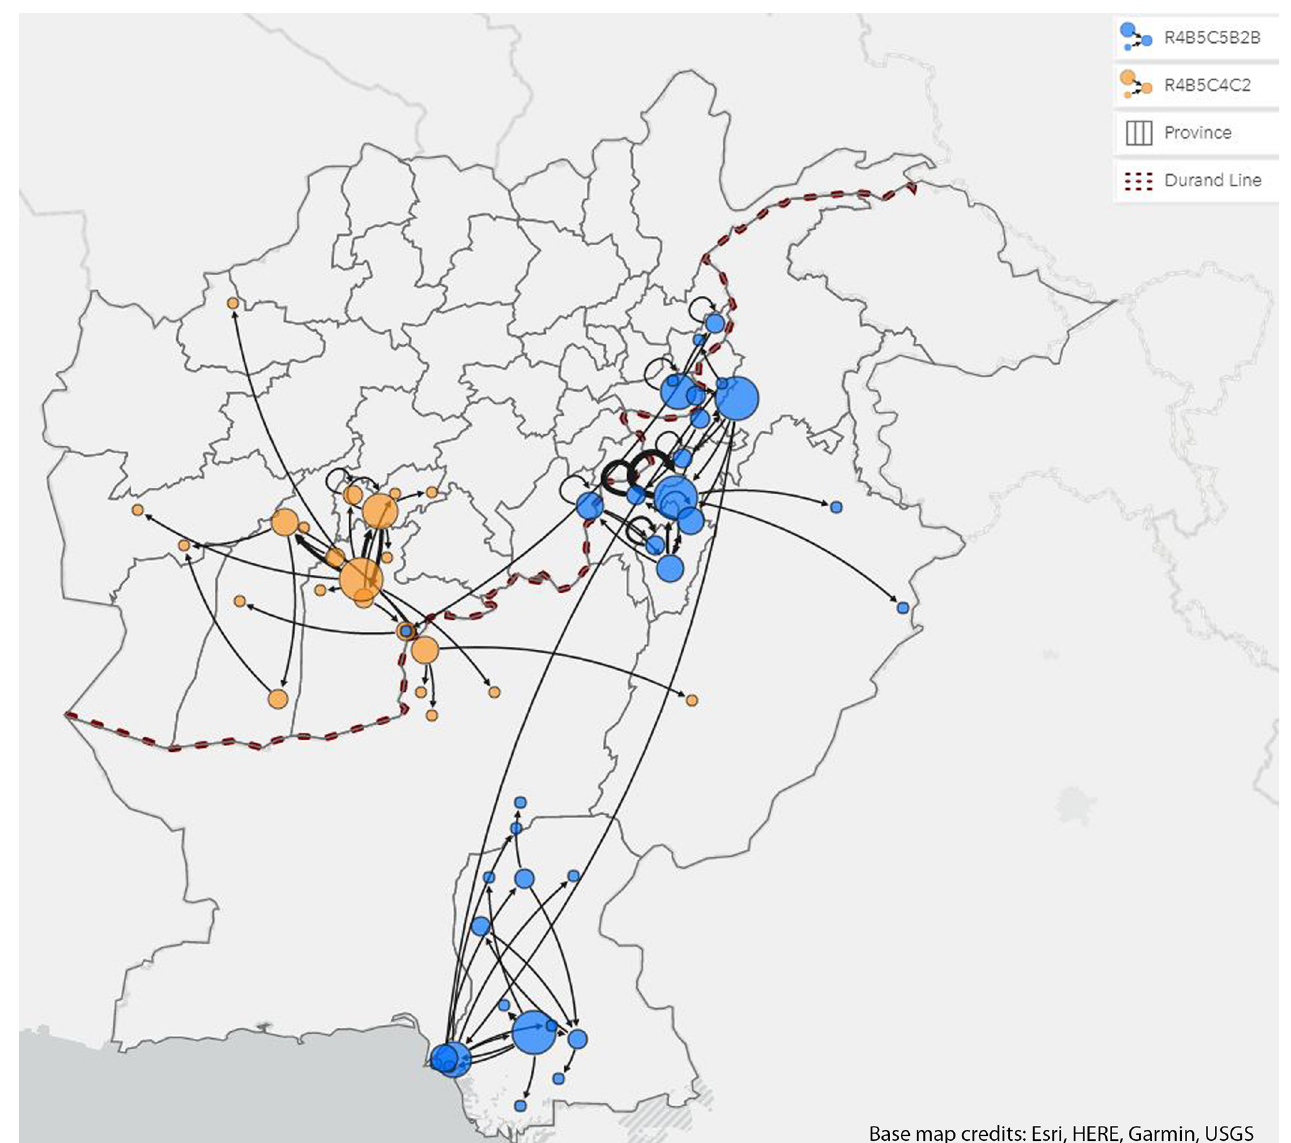
Fig 2. Inferred pattern of transmission of WPV1 in genetic clusters R4B5C4C2 (yellow) and R4B5C5B2B (blue). Base map service credits- Esri, HERE, Garmin, (c) OpenStreetMap contributors, and the GIS user community [8]. Note- A. Proportional symbols depicted as circles, indicate the number of closest identity matches an original Viral Protein 1 (VP1) sourced. B. The arrows are indicative of locations where the closest identity matches an original VP1 sourced. C. The arrows are indicative of locations where the closest identity match to a sequence was identified and does not represent directionality. D. The thickness of each arrow measures the influence of a